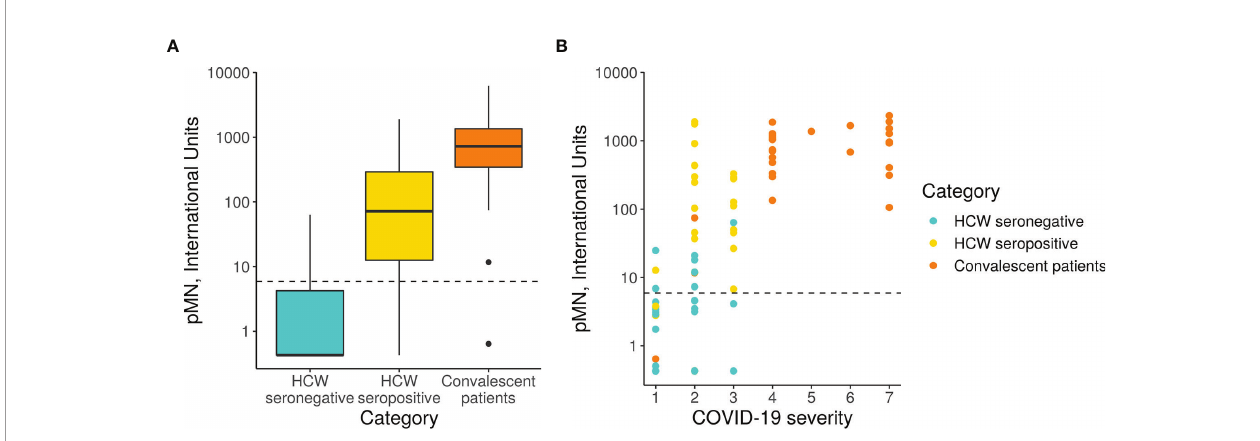
FIGURE 3 | pMN virus neutralisation in International Units by cohort and COVID-19 severity. (A) Boxplot showing the difference between cohorts. (B) Scatterplot showing neutralisation against disease severity. The dotted line shows the 95% upper CI calculated from pre-pandemic sera, 5.9 International